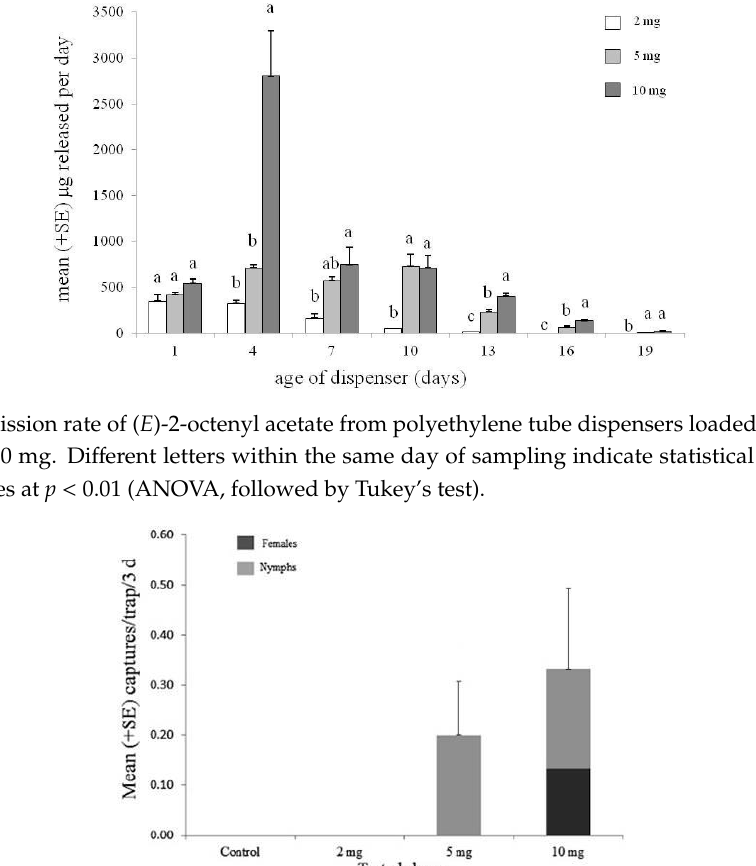
Figure 4. Mean number (+SE) of Bagrada hilaris individuals captured by traps baited with ( E )-2-octenyl acetate at different doses and the solvent (control); χ 2 = 8.24; df = 3; p <